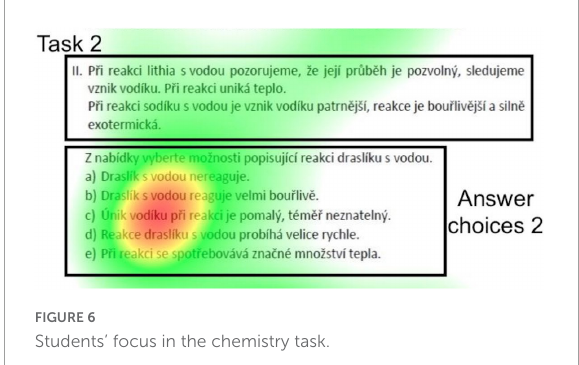
FIGURE6 Students’ focus in the chemistry task.